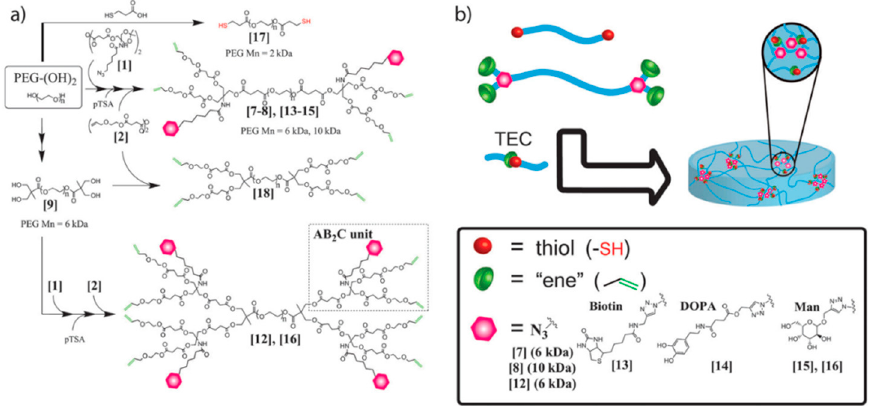
Figure 19. ( a ) Building blocks of hydrogel; ( b ) scheme for hydrogel formation. Adapted from [47]; published by The Royal Society of Chemistry.